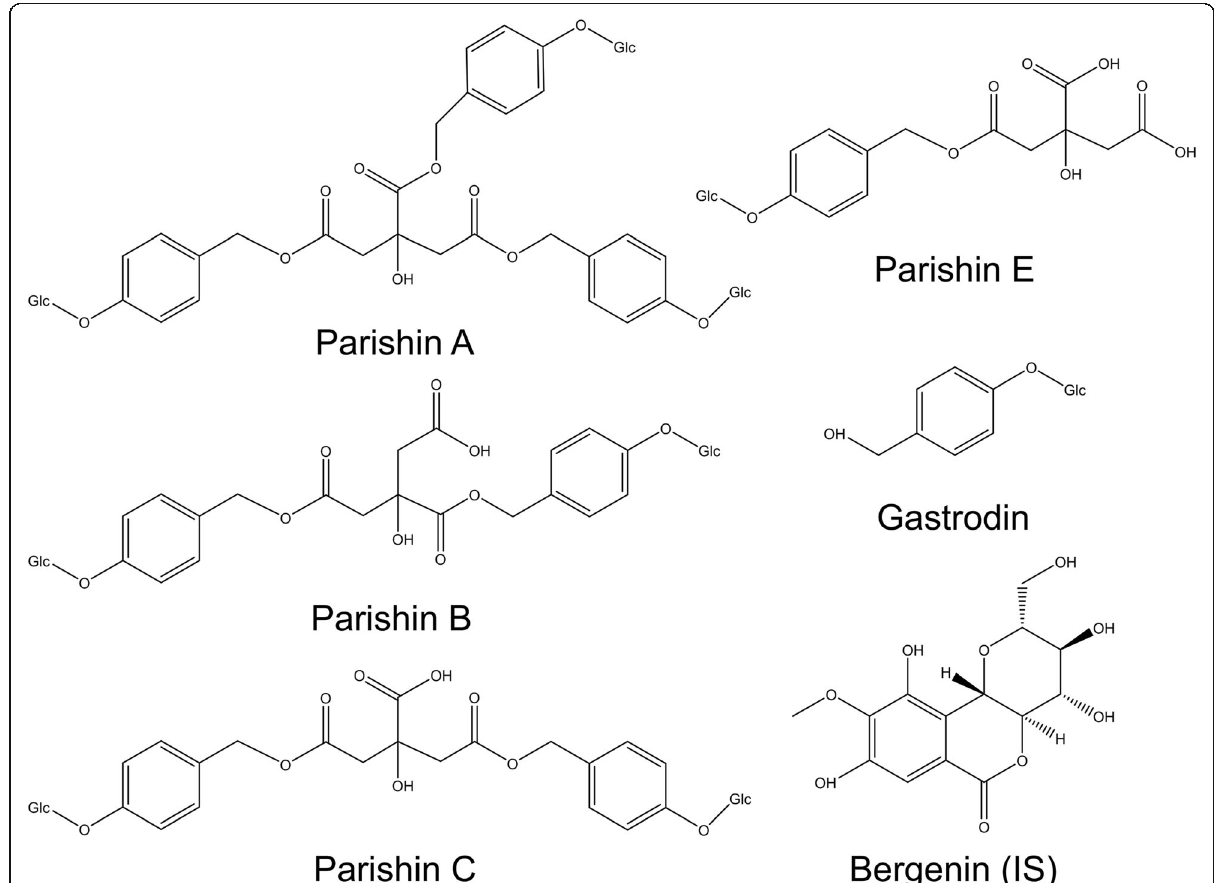
Fig. 1 Chemical structures of five compounds and internal standard. Glc, β